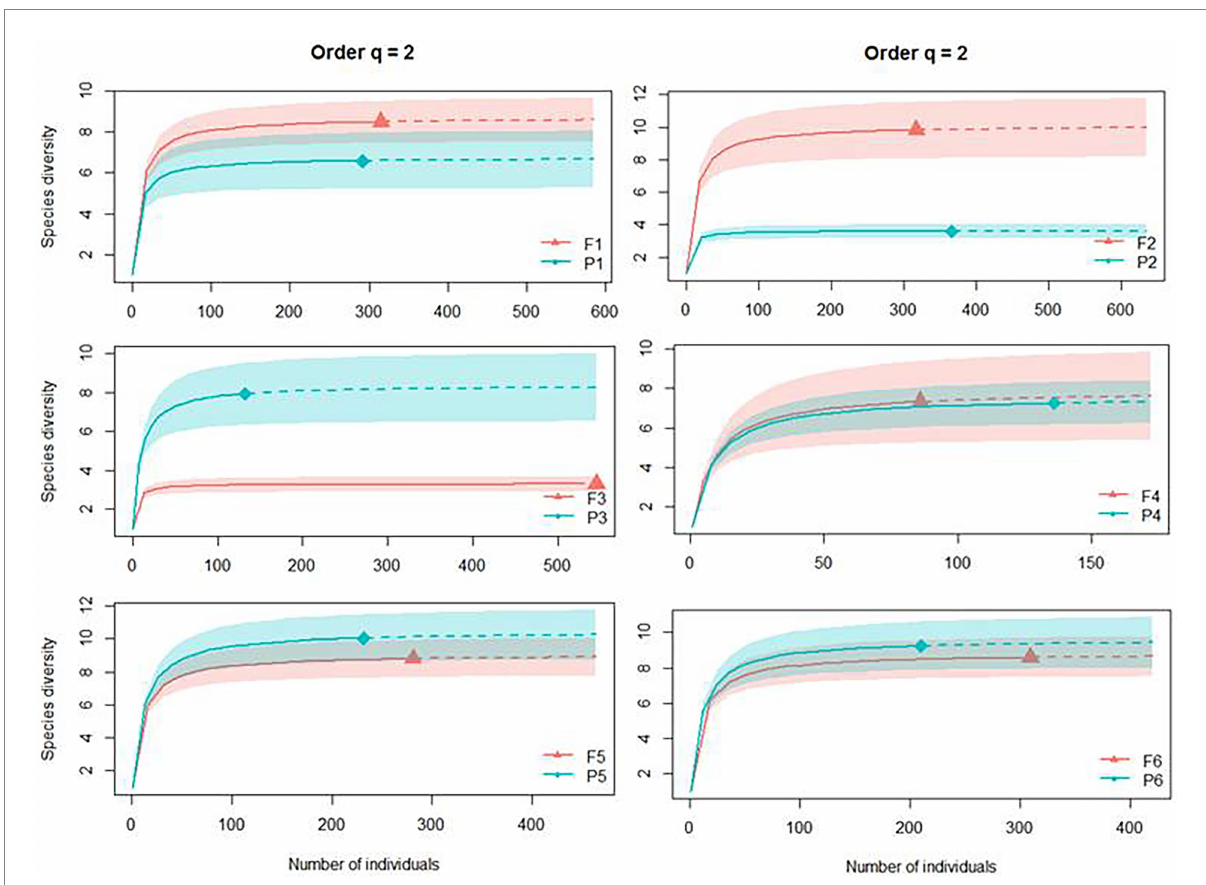
FIGURE 5 Individual-based rarefaction (solid lines) and extrapolation (dashed lines, up to double the sample size) of Dung beetle diversity for Hill numbers (q = 2) for each site, where F represents native forests and P represents Pinus